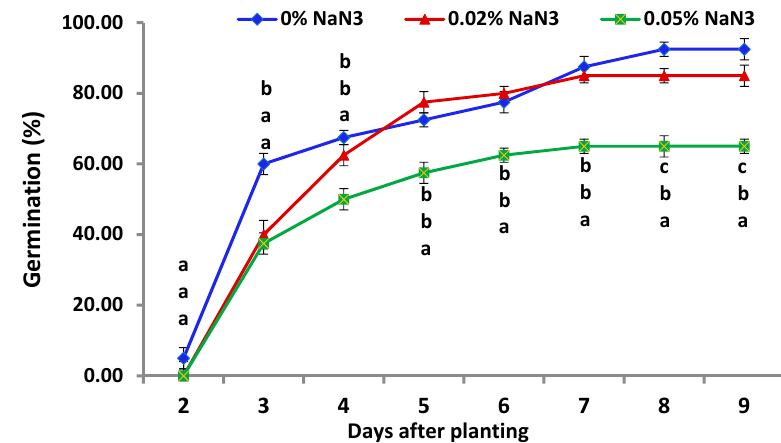
Figure 1. Percentage of germination of NaN 3 -treated okra seeds sown in nursery. Values = mean ± SD, n = 4. Mean values with similar letters at the same day after planting (DAP) are not significantly different at p ≤ 0.05.